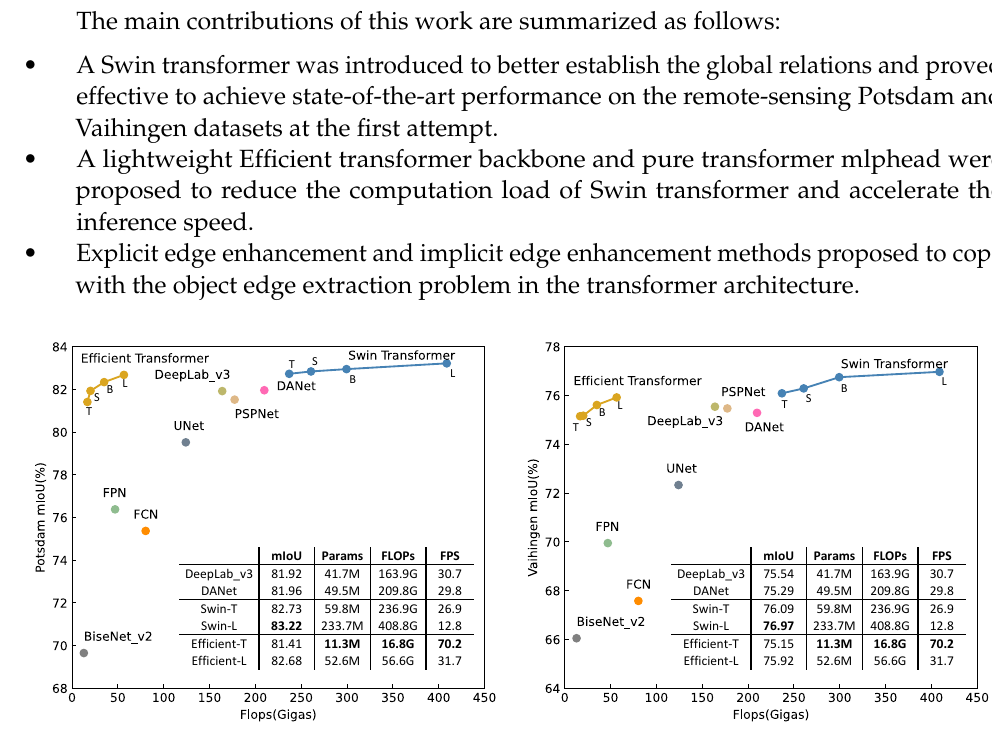
Figure 1. Flops vs. mIoU on the Potsdam and Vaihingen